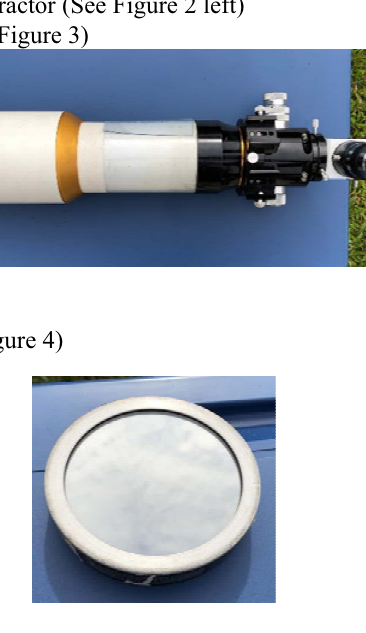
Figure 4. White Light